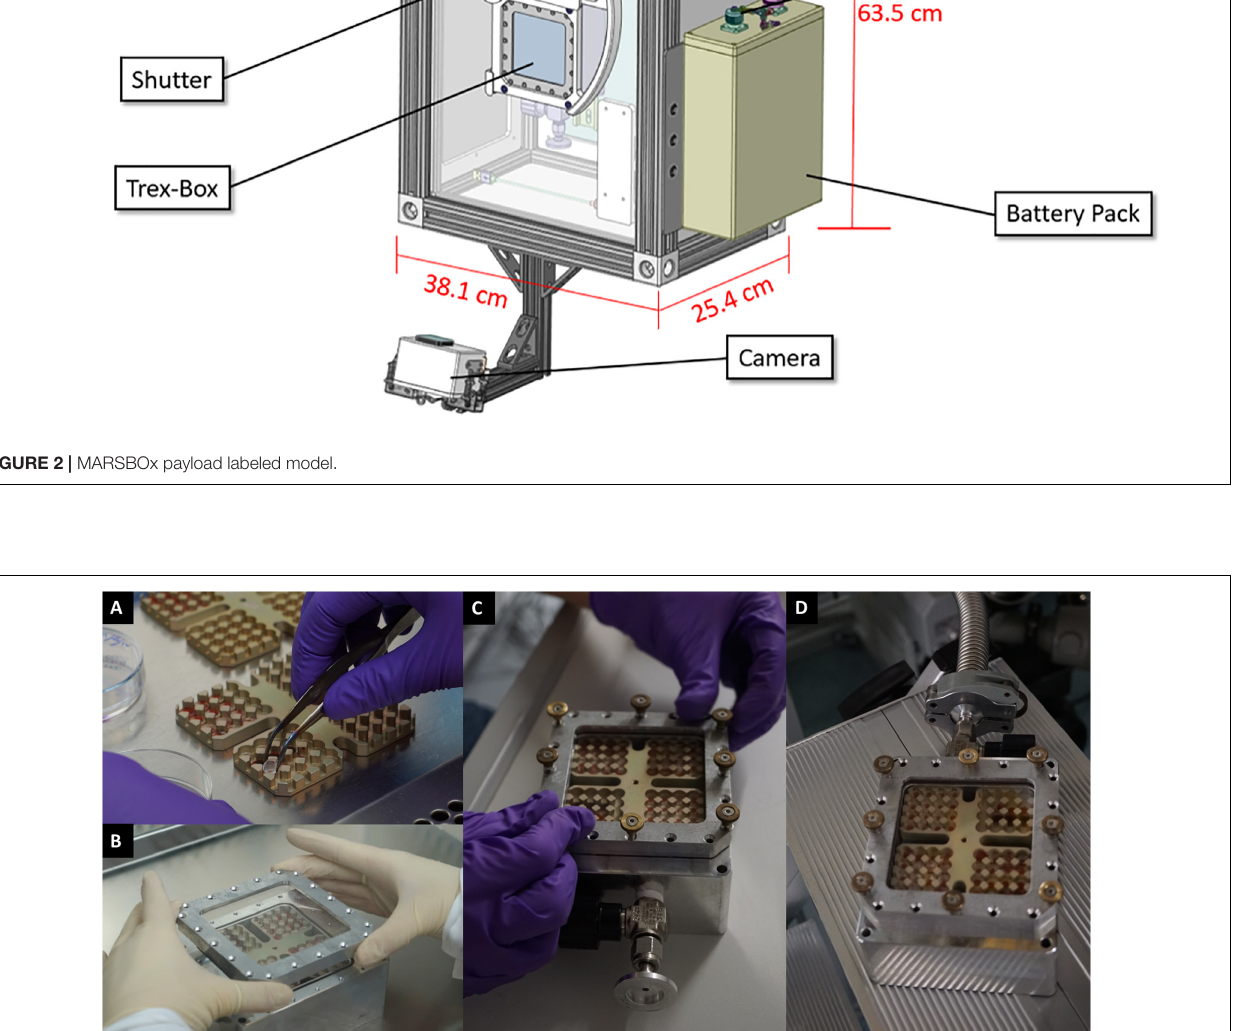
Frontiers in Microbiology |